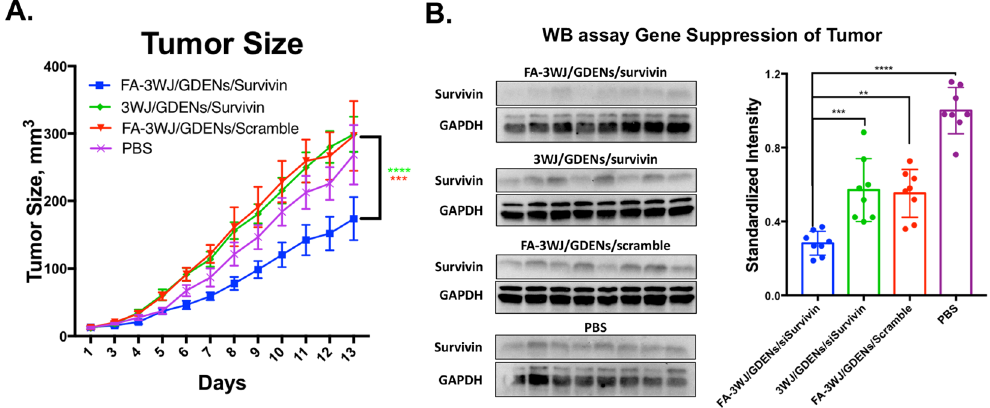
Figure 8. In vivo delivery of siRNA by ligand-displaying GDENs via IV injection. ( A ) Tumor size of nude mice with KB cell derived xenograft tumors by intravenously treatment every two days for two weeks. n = 8 and result is shown as mean ± S.E.M., analysis by multiple t-test. p = 0.0378, 0.0179, 0.0035, 0.0015, 0.0018, 0.0008 for day 8~13 post first dose given, respectively, for FA-3WJ/GDENs/siSurvivin v.s. FA-3WJ/GDENs/Scramble control. p = 0.0026, 0.0015, 0.0002, < 0.0001, < 0.0001, < 0.0001 for day 8~13 post first dose given, respectively, for FA-3WJ/GDENs/siSurvivin v.s. 3WJ/GDENs/siSurvivin. ( B ) Western blot evaluating survivin protein level in tumor after intravenously treatment (All cropped blots were run under same condition and developed